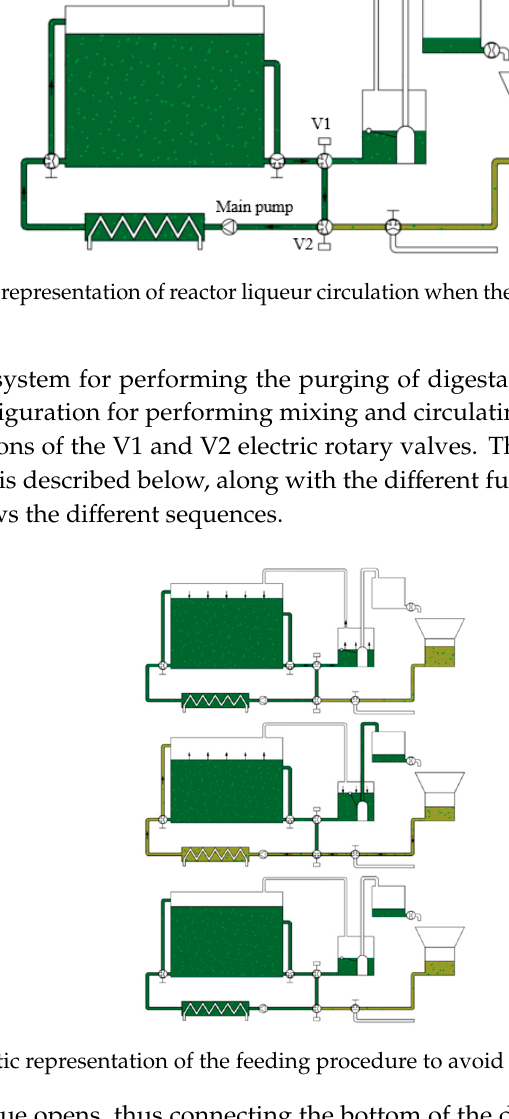
Figure 6. Representation of the configuration of the heating system designed for keeping the temperature of anaerobic reactor.